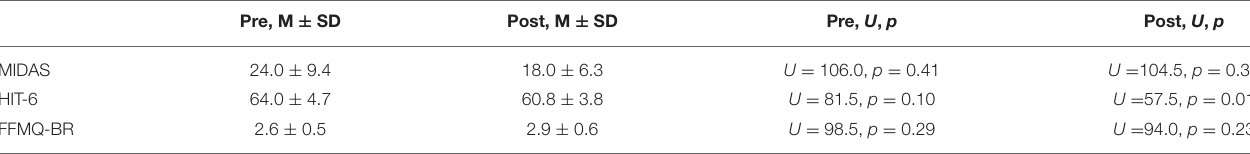
TABLE 3 | Intergroup comparison of the three clinical outcomes in pre and post treatment of active and sham conditions (active tDCS: n = 16, sham tDCS: n = 14).